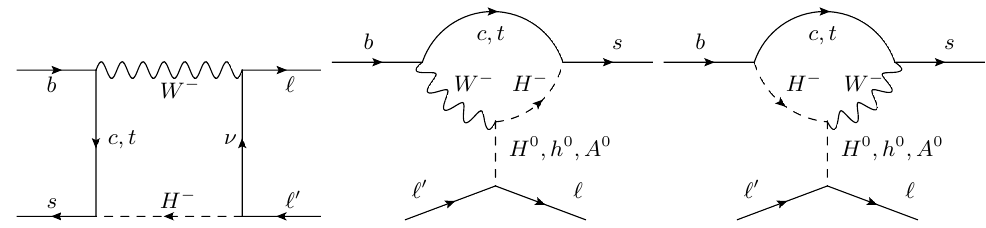
in eq. (3.35). S ( P )( HW )